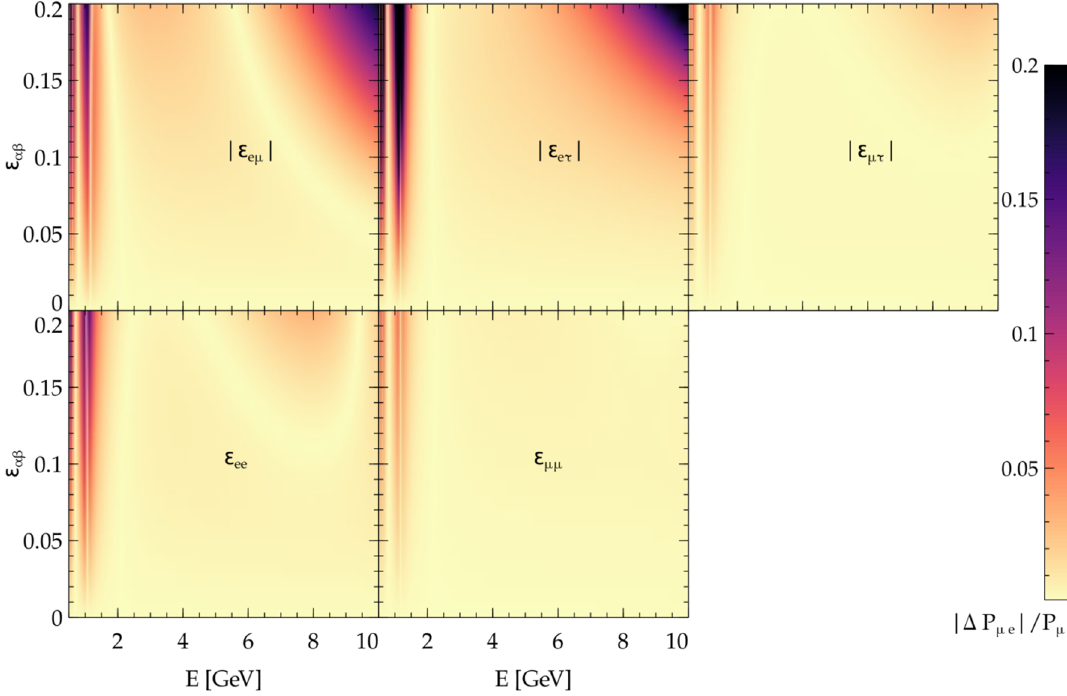
Figure 3 . Heatmap for | ∆ P µe | /P µe as a function of the NSI parameters ε eµ , ε eτ , ε µτ , ε ee , ε µτ (taken one-at-a-time and assuming them to be real) and the neutrino energy, E